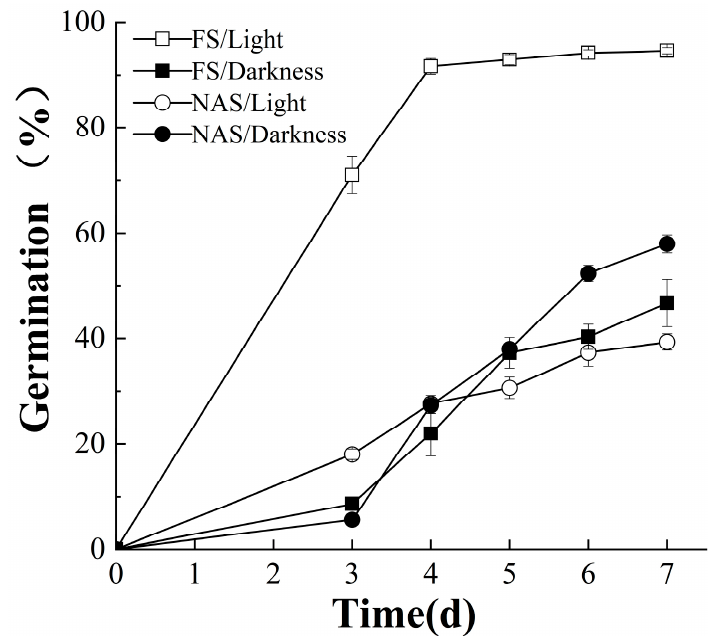
Figure 1. Light promotes and inhibits germination of freshly harvested seeds (FS) and naturally aged seeds (NAS), respectively. Percentage of germinating seeds kept in darkness (black graphics, the same Figs below) or under 12h light/dark (white graphics, the same Figs below) cycle and 325 μ mol m − 2 s − 1 white light condition, scored over time.